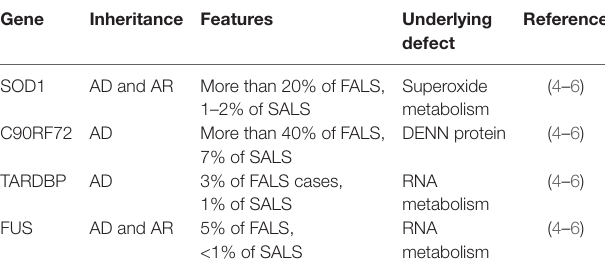
TABLe 1 | Genetic mutations associated with